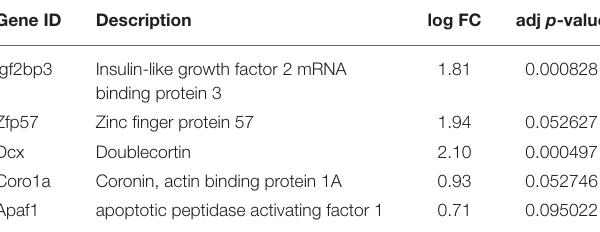
TABLE 8 | Genes selected from the microarray for qPCR